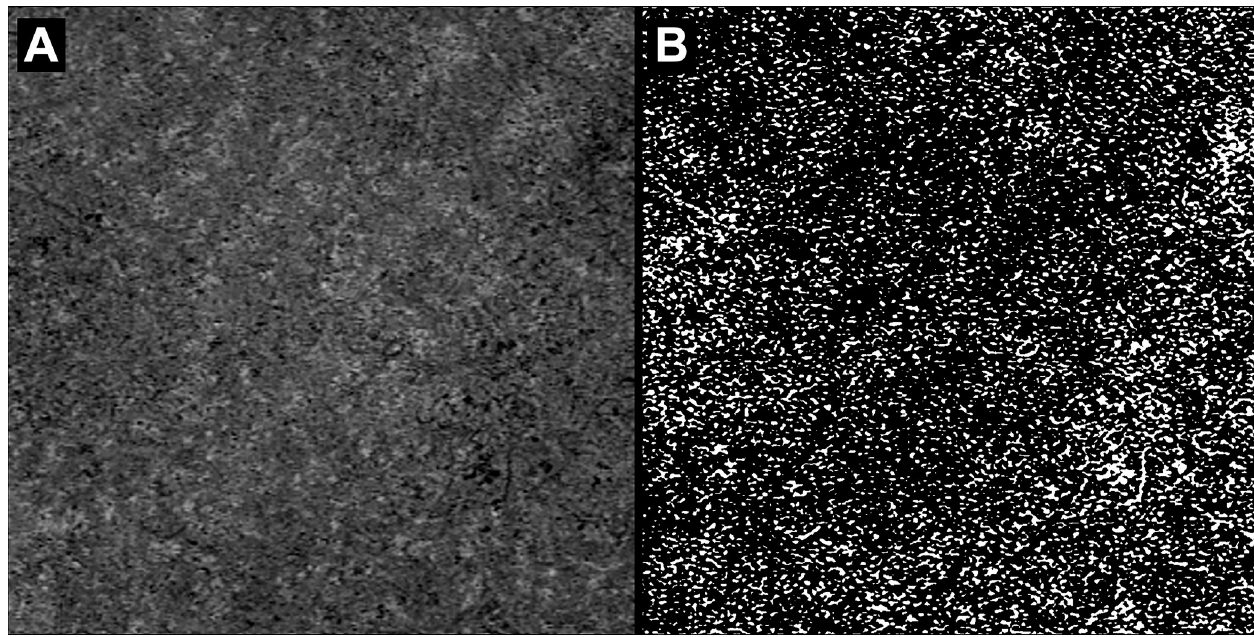
Fig 1. En face swept-source OCTA choriocapillaris images before and after automatic local thresholding are shown. (A) A choriocapillaris image obtained by a choriocapillaris slab with 20- μ m thickness at 29–49 μ m beneath the retinal pigment epithelium fit layer, with projection artifacts removal, is shown. (B) A choriocapillaris image thresholded with the Phansalkar method, using a radius of 6 pixels, is shown. OCTA, optical coherence tomography angiography.